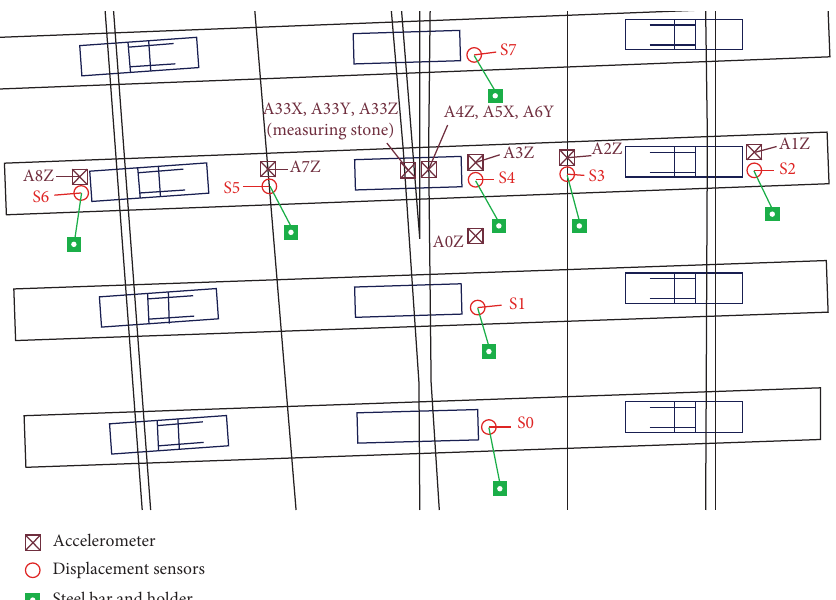
Figure 1: Measurement methodology used for data acquisition from the crossing part of the S&C.